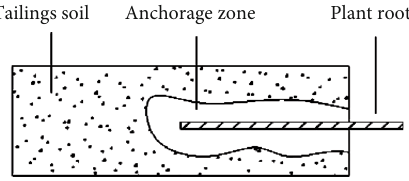
Figure 9: Schematic diagram of root soil